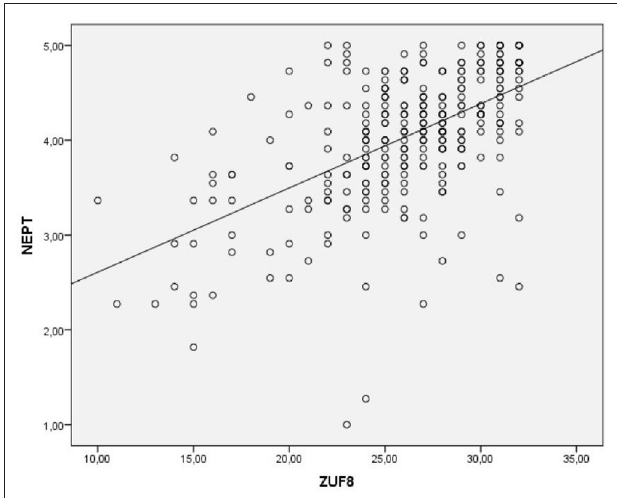
FIGURE 3 | Scatterplot presenting the linear relationship between the ZUF-8 total score and NEPT total score. ZUF-8, German version of the Client Satisfaction Questionnaire CSQ-8; NEPT, Needs and Experiences in Psychiatric Treatment scale. Solid line represents a hyppthetical 1:1 relationship between total scores of both